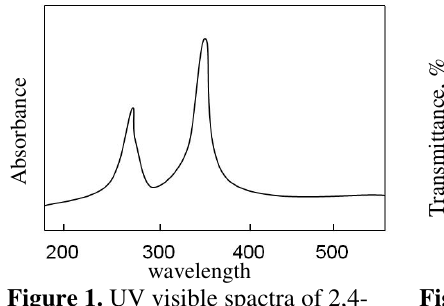
Figure 2 . Infrared spectra of 2,4- DHBAMF copolymer.